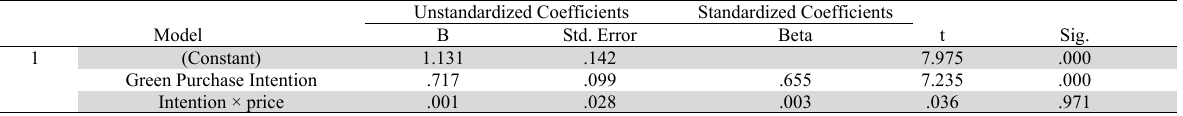
Multiple Regression of the Moderator